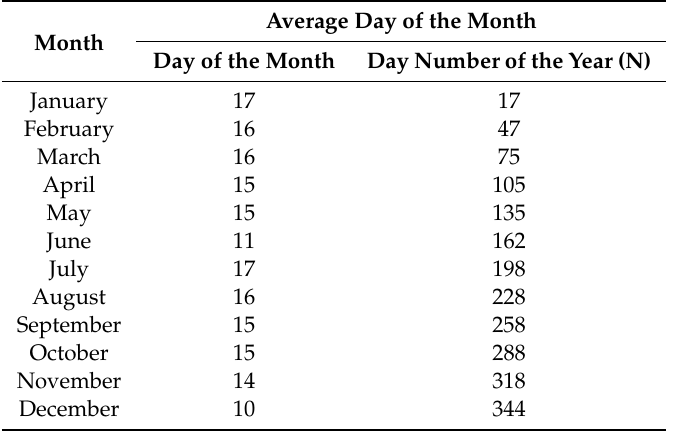
Table 2. Day numbers per month according to